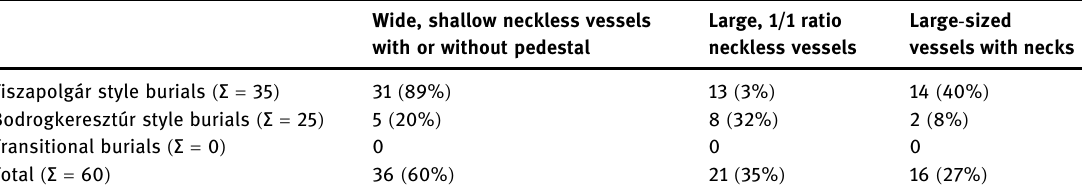
Table 4: The third ceramic morphometric type in graves containing the vessel combination of minimum one small, shallow neckless vessel and minimum one regular - sized vessel with neck at Tiszapolgár - Basatanya Wide, shallow neckless